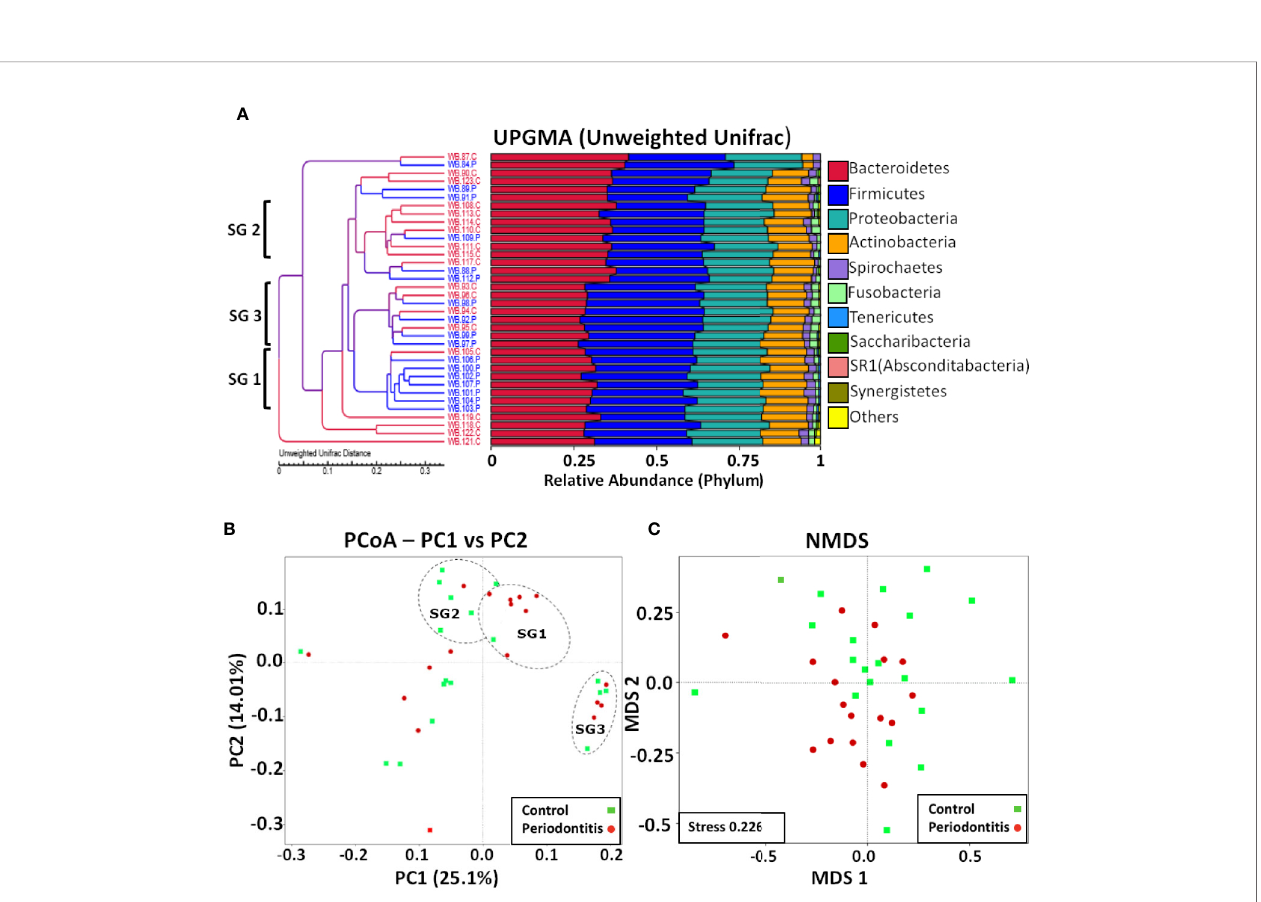
FIGURE 4 | Multivariate analyses of blood bacterial populations. (A) UPGMA of unweighted UniFrac distances showing percentage composition at the phylum level with three possible clusters suggested by brackets. (B) . PCoA of unweighted UniFrac distances with healthy samples shown in green and periodontitis samples in red and possible clusters (SG1, SG2, and SG3) suggested by UPGMA indicated (for descriptive purposes only) with dashed outlines. (C) NMDS analysis showing possible partial partitioning according to health and